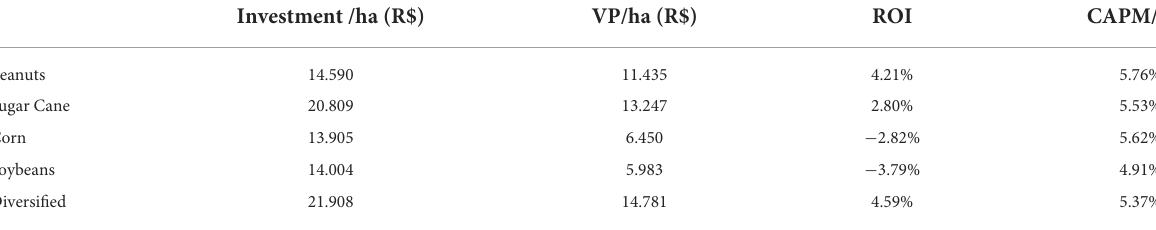
TABLE 5 Investment, PV/ha, ROI, and CAPM/Risk for the studied scenarios.